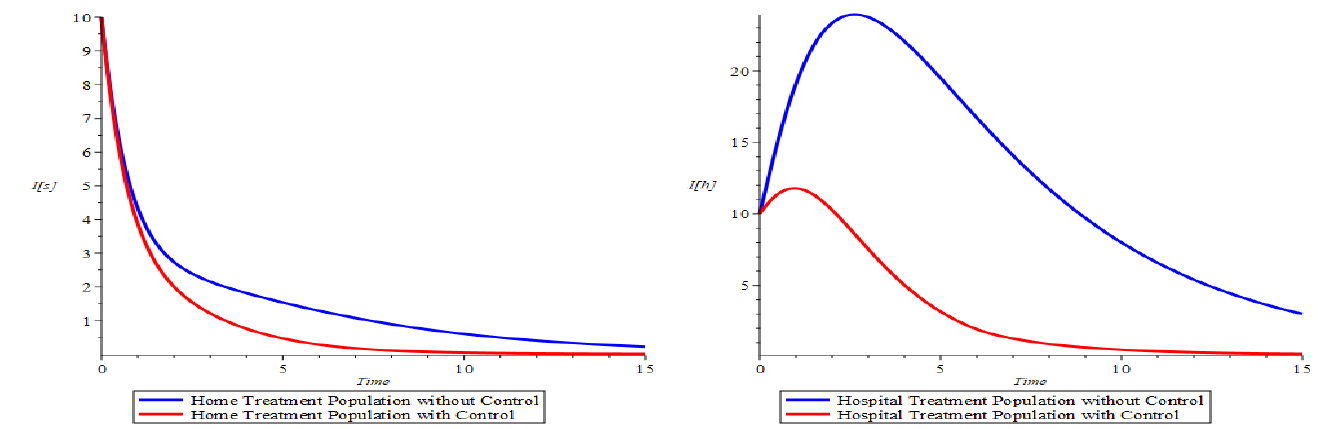
Figure 12. The impact of optimal control on the compartments I S and I H